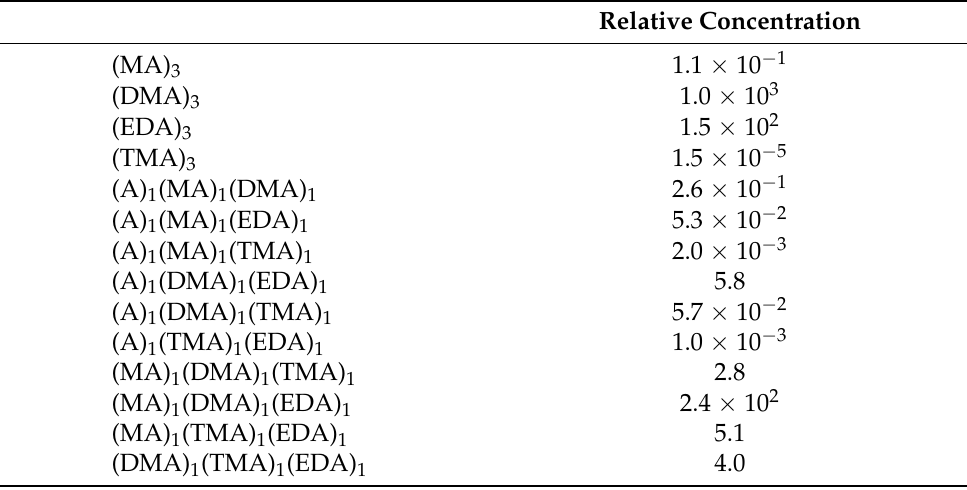
Table 3. Calculated scaled relative cluster equilibrium concentration compared to the (SA) 3 (A) 3